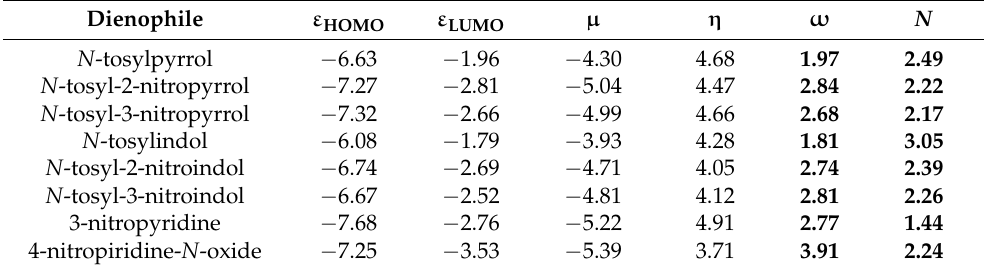
Table 2. Global properties calculated using B3LYP method and 6-311+G(d,p) level of theory. Dienophile ε HOMO ε LUMO